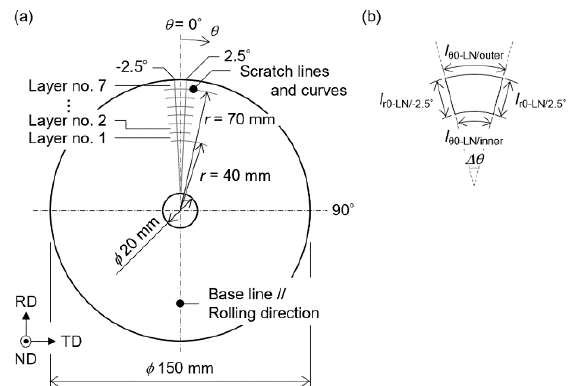
Table 1. Chemical composition of the blank aluminum disks (mass %).